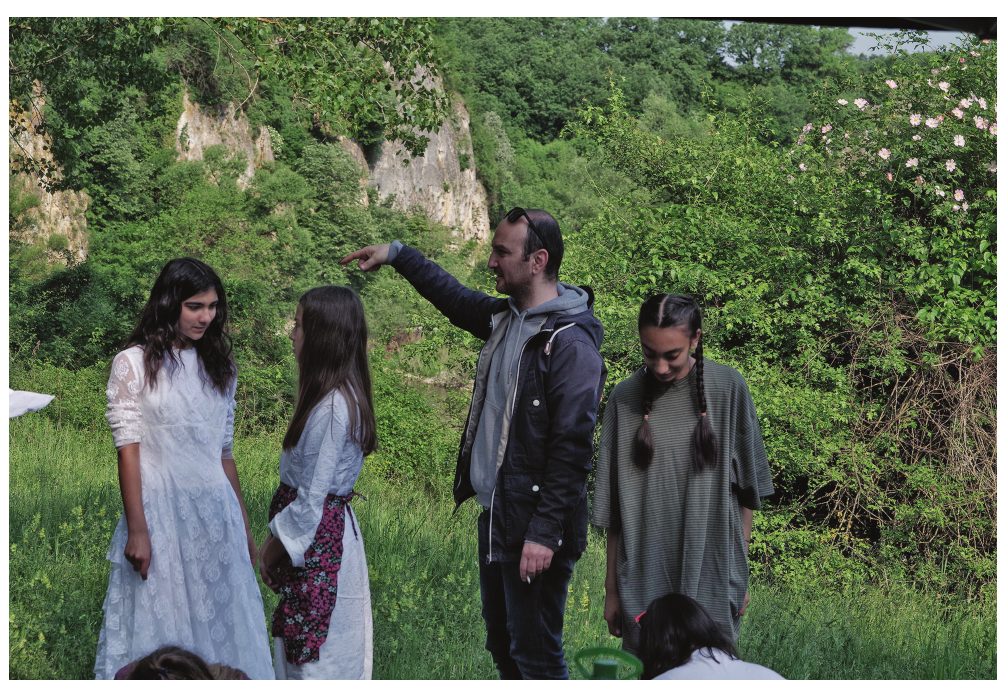
Figure 3: The shooting of 9 + 1 , filmed for CCAJ 2017/18